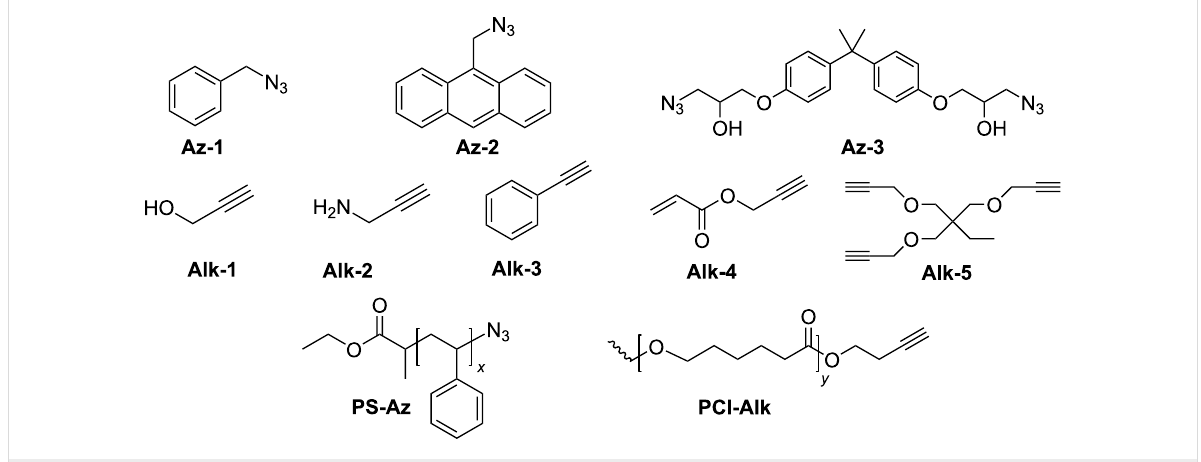
Figure 1: Structures of azide and alkyne functional molecules and polymers used in the photoinduced CuAAC reactions.